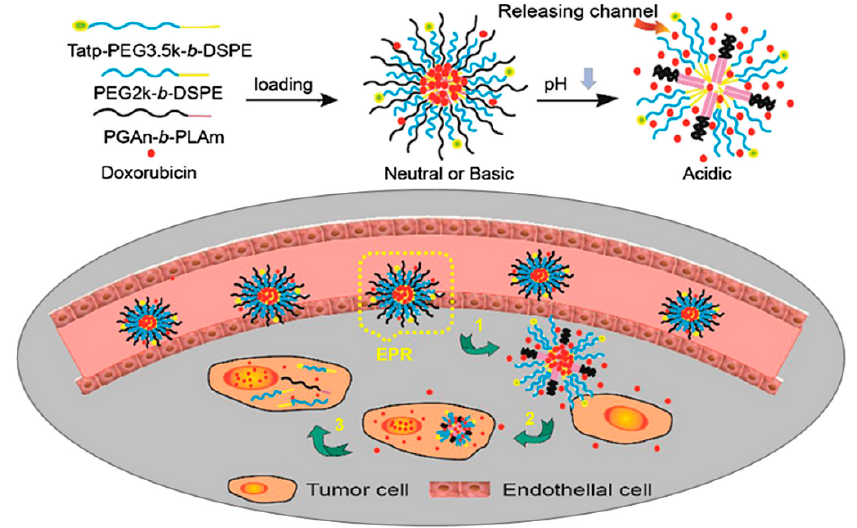
Figure 14. Schematic representation of intracellular delivery of doxorubicin using poly( L